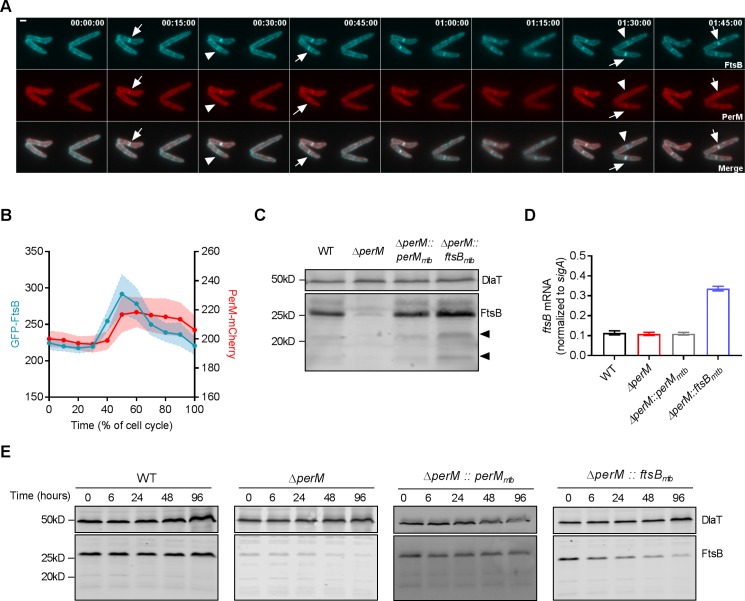
PerM co-localizes with FtsB and stabilizes FtsB.(A) Representative image series from time lapse movies of replicating M. smegmatis constitutively expressing both GFP-FtsBmtb and PerMmtb-mCherry over the duration of 1 hr and 45 mins. Arrows point to the presence of both FtsB and PerM at the mid-cell, and arrowheads point to the presence of FtsB and lack of PerM at the mid-cells. Scale bar, 1 µm. Numbers in the upper right corner indicate time. (B) Measurements of the maximum fluorescence intensities of GFP-FtsB and PerM-mCherry as a function of the cell cycle from time lapse movies shown in (A). The lines and shaded areas indicate means and the 95% confidence intervals of 20 bacteria. (C) FtsB protein in whole-cell lysates of log-phase Mtb measured by western blotting with anti-FtsB antibody. Arrowheads point to cleavage products of FtsB. Dihydrolipoamide acyltransferase (DlaT) was used as loading control. (D) FtsB mRNA in log-phase Mtb culture measured by quantitative real time PCR. mRNA levels were normalized to expression of the housekeeping gene sigA. Data are means ± SD of triplicates. (E) Detection of FtsB in whole-cell lysates collected from Mtb strains by western blotting with anti-FtsB antibody. 20 µg/ml chloramphenicol were added to each culture at time 0 to inhibit protein synthesis and samples were collected at the indicated time points. Western blotting with anti-DlaT was used as loading control. Data in (C–E) are representative of two independent experiments. Biological replicates of Figure 5C and E are shown in Figure 5—figure supplement 3.